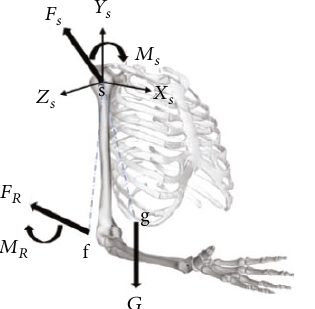
Figure 3: Shoulder joint frame system and upper limb stress.